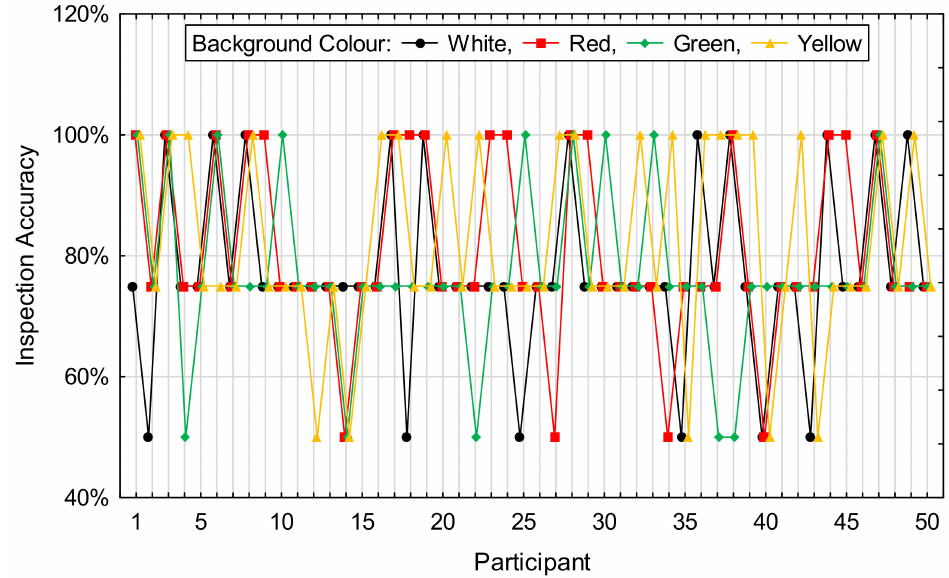
Figure 15. Effect of background colour on the individual inspection accuracy (without standard deviation for legibility purposes). The diagram shows high personal preference for specific